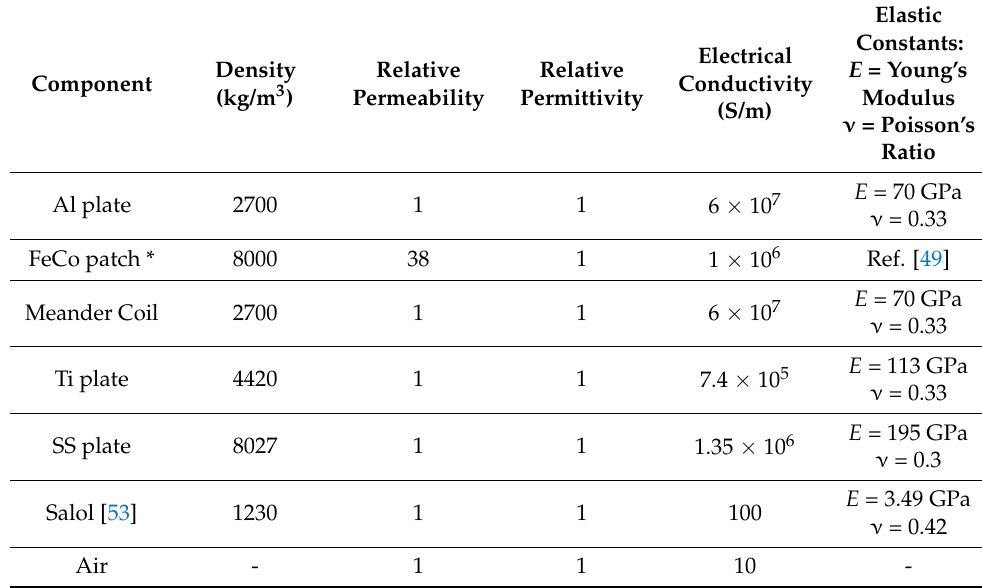
Table 2. Material properties for each component in the MST/plate model.